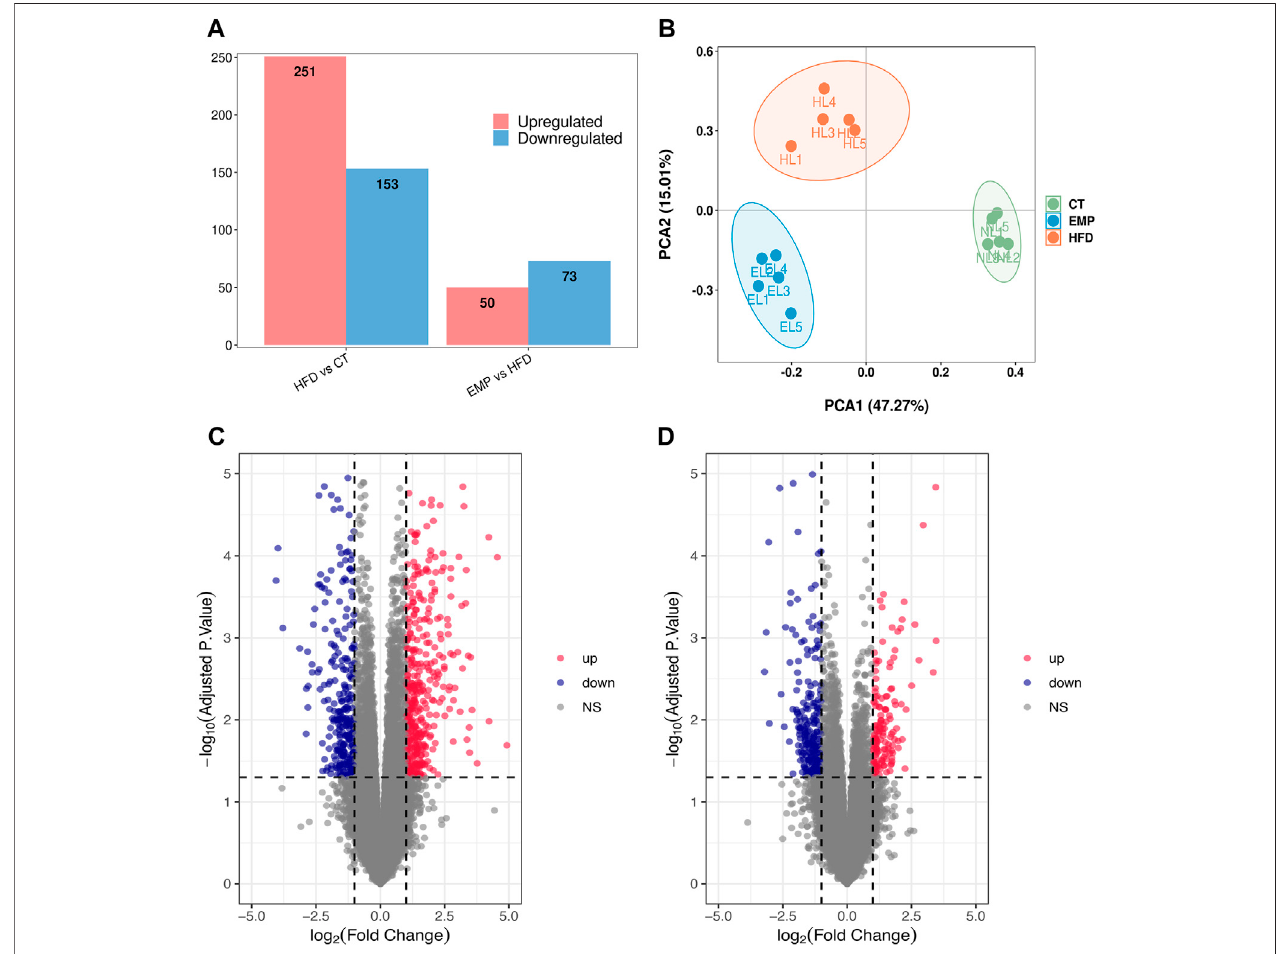
FIGURE2| Comparisonoftranscriptomepro fi ling. (A) Thegenenumberofup-regulationanddown-regulationinHFD/CTandEMP/HFD. (B) PCAanalysisofthree groups. (C) The volcano plots for the distribution of differently expressed genes between HFD and CT group. Blue represents a down-regulation in expression, red represents upregulation and gray represents no signi fi cance when compared with control. (D) The volcano plots for the distribution of differently expressed genes between EMP and HFD group.